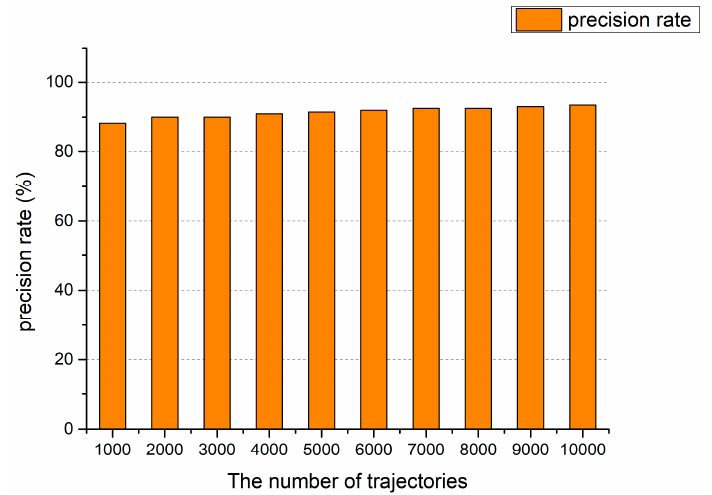
Figure 7. Prediction accuracy of different numbers of historical trajectories.